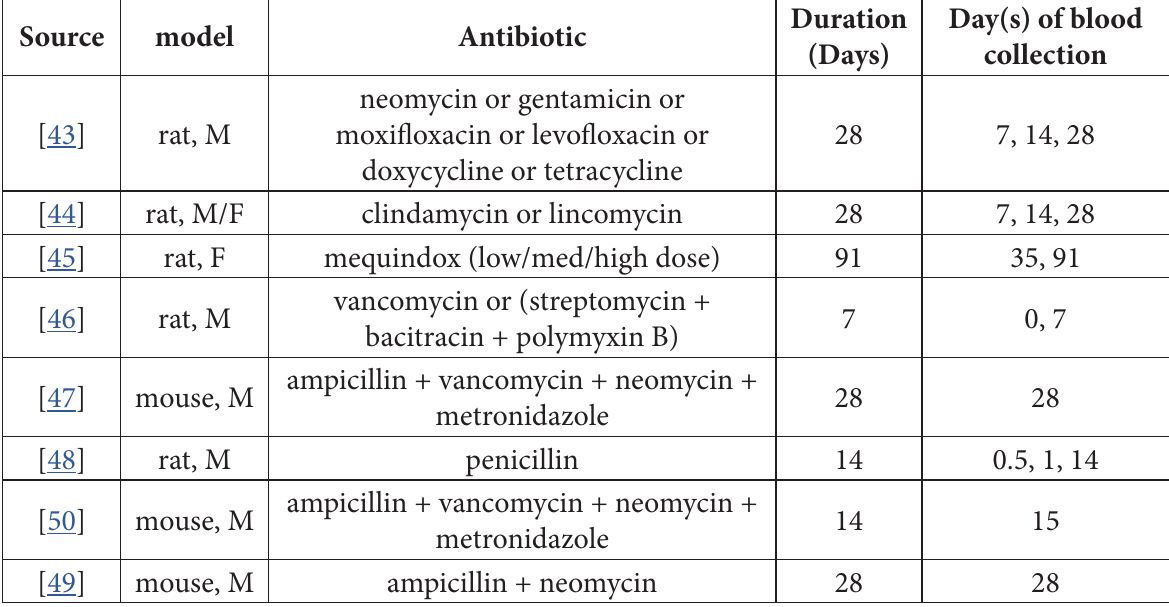
Table 1: Antibiotic Effects on Small Molecules in the Serum of the Mouse or Rat